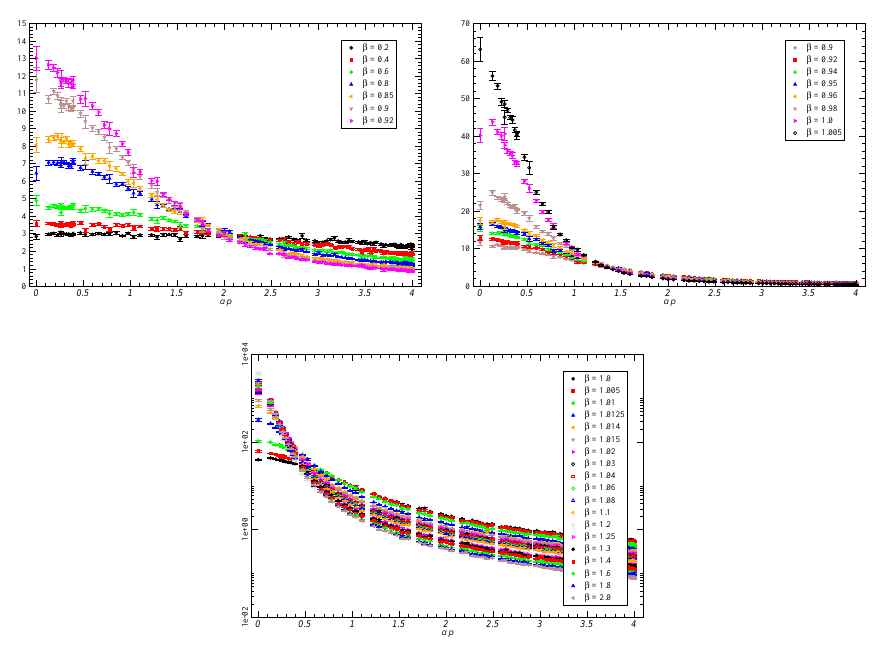
Figure 4. The bare photon propagator as a function of β